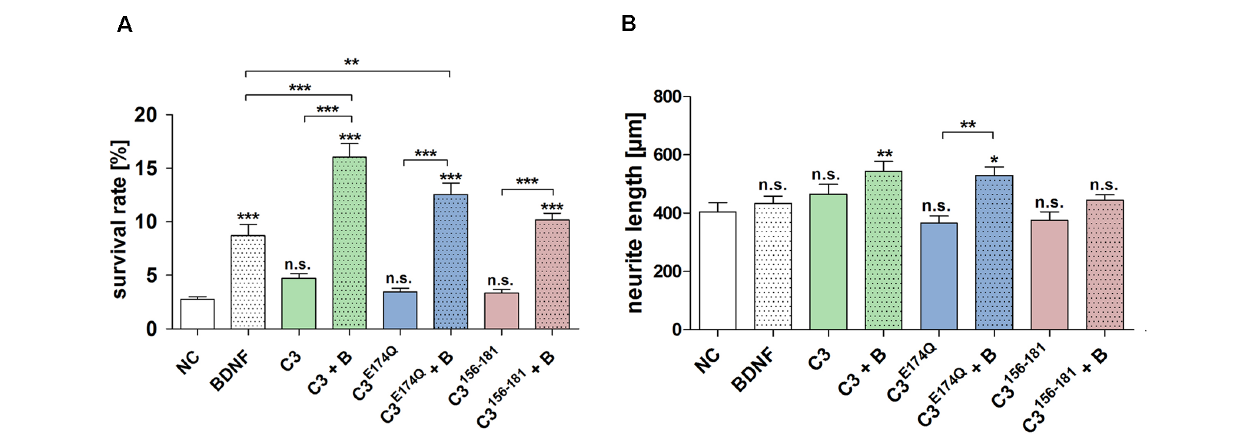
FIGURE 3 | Effect of the different constructs of C3 exoenzyme on the survival rate and neurite length of SGN. (A) Treatment of SGN with C3, C3 E174Q , or C3 156 − 181 (50 nM) for 48 h did not increase the survival rate. Thus, only in combination with BDNF, the survival rates of SGN were significantly increased when compared to the negative control (NC; medium control). This effect was also detected when compared to its respective C3 construct alone. The combination of C3 and C3 E174Q with BDNF significantly increased the survival rate of SGN when compared to the BDNF control (50 ng/ml). (B) The neurite length of SGN did not show a significant increase when treated with the C3 alone. However, the combination of C3 and BDNF resulted in a significantly enhanced neurite length with p < 0.01 when compared to the control. This condition obtained the maximum of all measured neuronal lengths. The enzymatically inactive mutant C3 E174Q showed in combination with BDNF a significantly increased neurite length when compared to its pure application. Asterisks over the error bars represent the respective significance when compared to the NC, either for the survival rate or for the neurite length. NC, negative control; BDNF/B, brain-derived neurotrophic factor (BDNF); n.s., not significant.